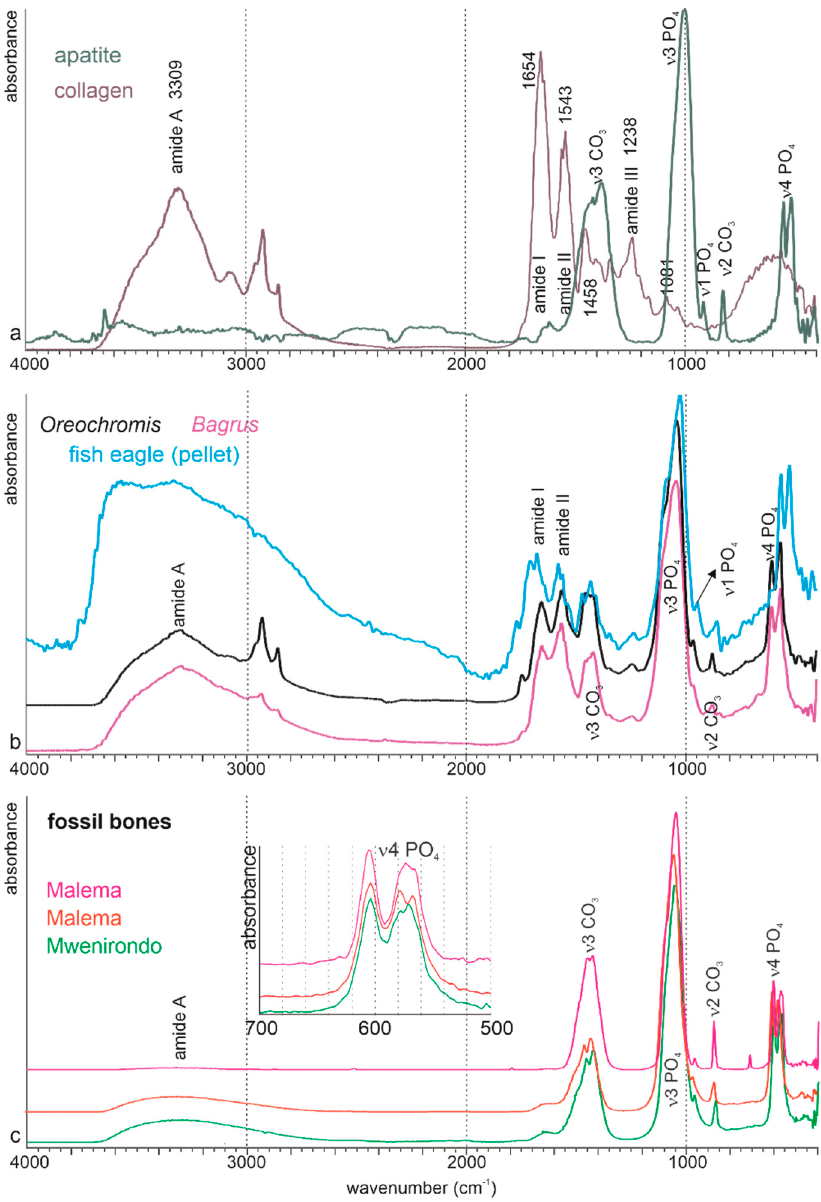
Figure 8. Fourier transform infrared spectrometry on powdered samples of fish bones. ( a ) Geological apatite and commercial collagen type B used as standards. ( b ) Modern bones: two fresh bones ( Bagrus and Oreochromis ) showing the mixed organic + mineral composition. The composition of a bone extracted from a modern pellet is modified. ( c ) Examples of fossil bones, showing the loss of organic components. Insert: detailed zone used for calculation of the crystallinity index.